Question: Which kind of chart has been used to present this data?
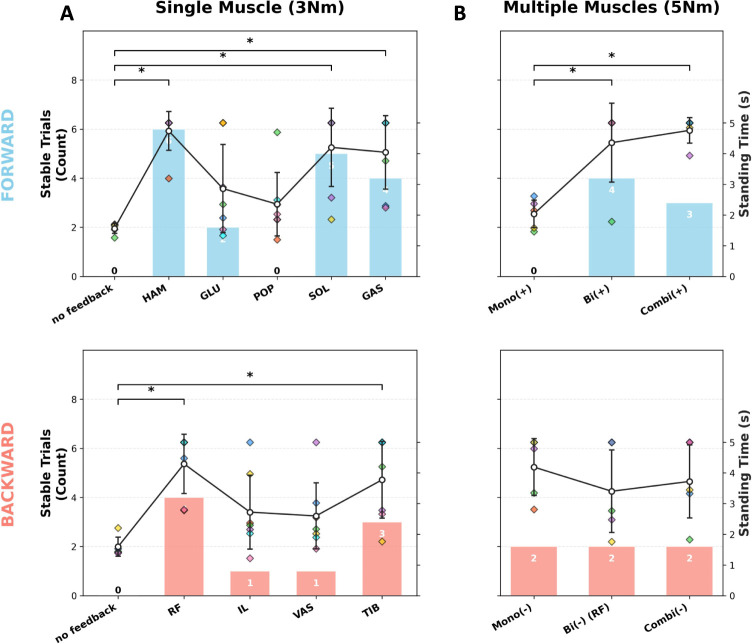
Answer: scatter